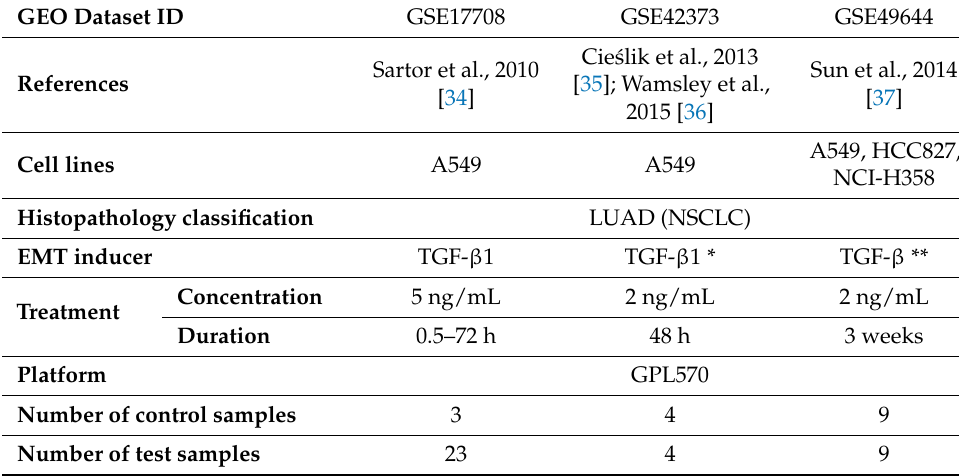
Table 1. Description of the microarray datasets selected for the